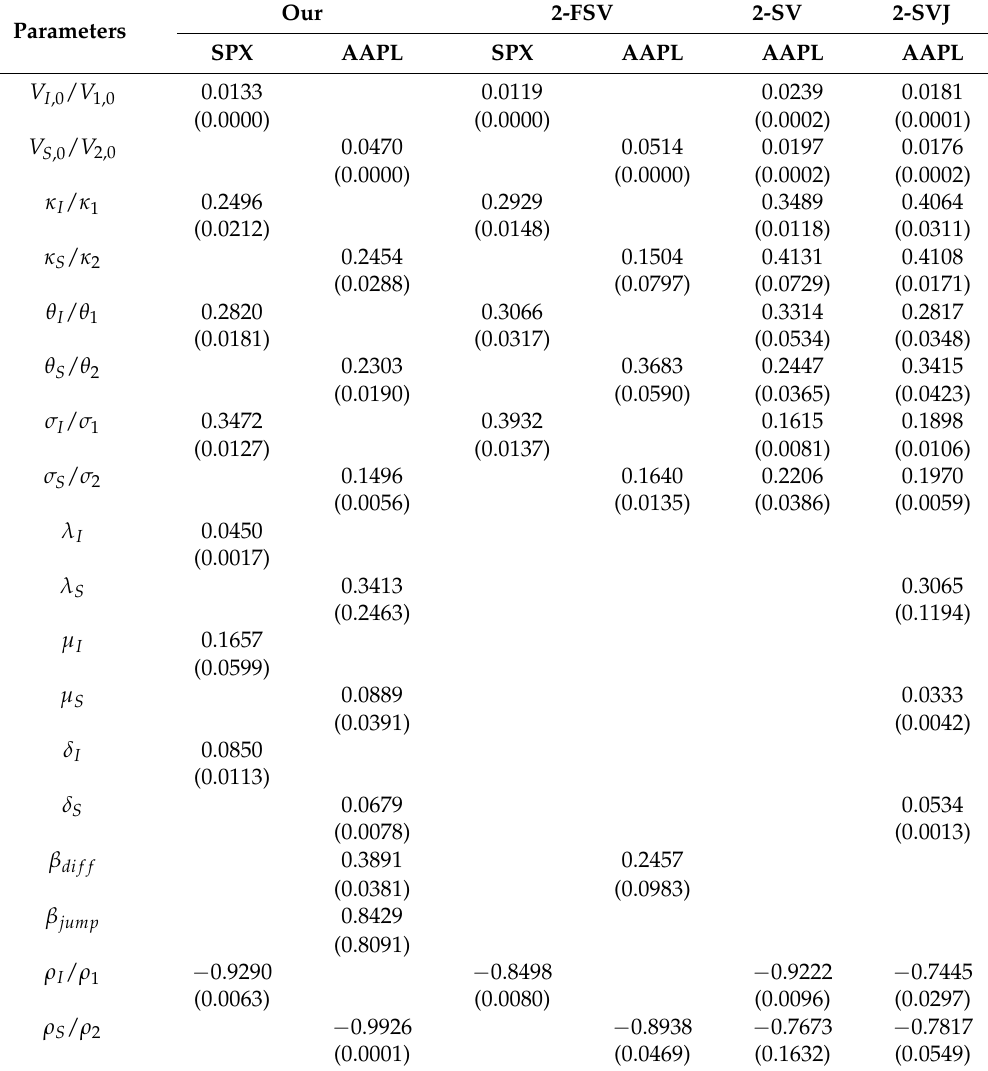
Table 1. Estimated parameters. Note: This table shows the average of the estimated parameters obtained by minimizing the root mean squared pricing errors between the market price and the model price for each option on 8 May 2019. Standard errors are reported in parentheses